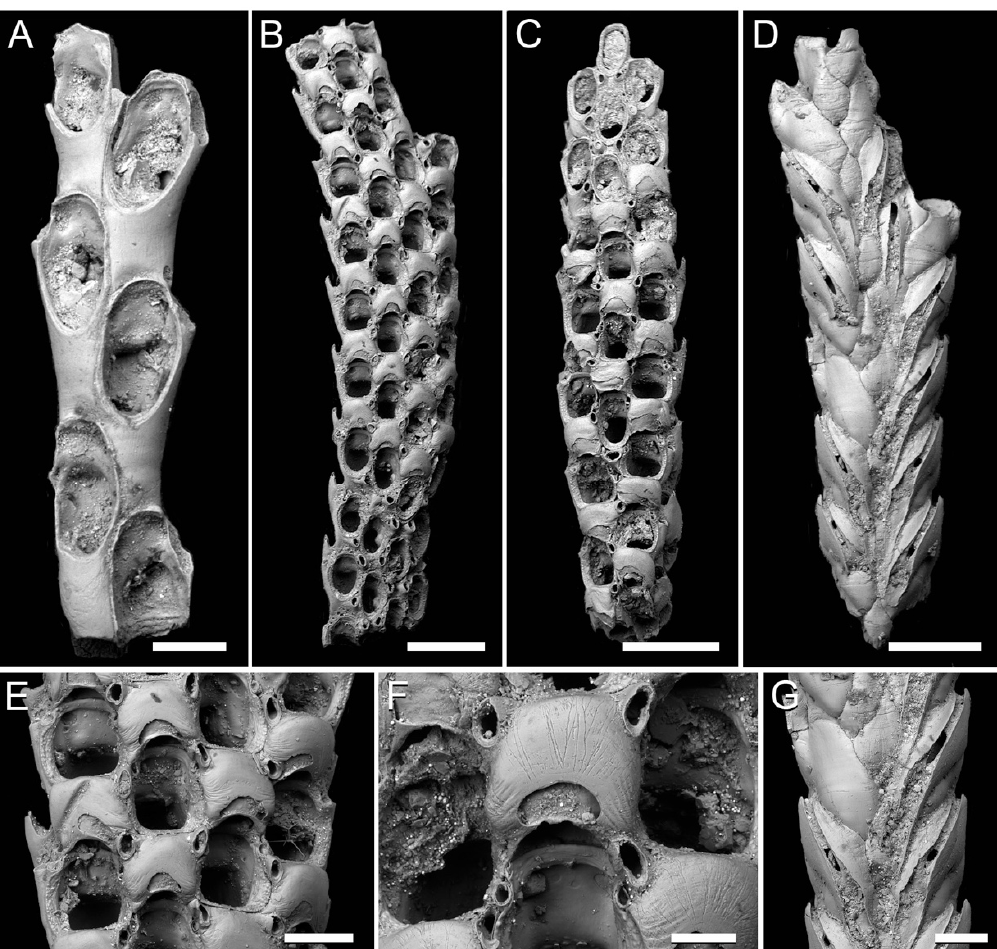
Figure 3. Cheilostome bryozoans from the Clyde Clay Formation of Garvel Park, Greenock, Scotland. ( A ) Bugulopsis peachii (Busk, 1851), small branch showing biserial arrangement of autozooids on the frontal surface, NHMUK